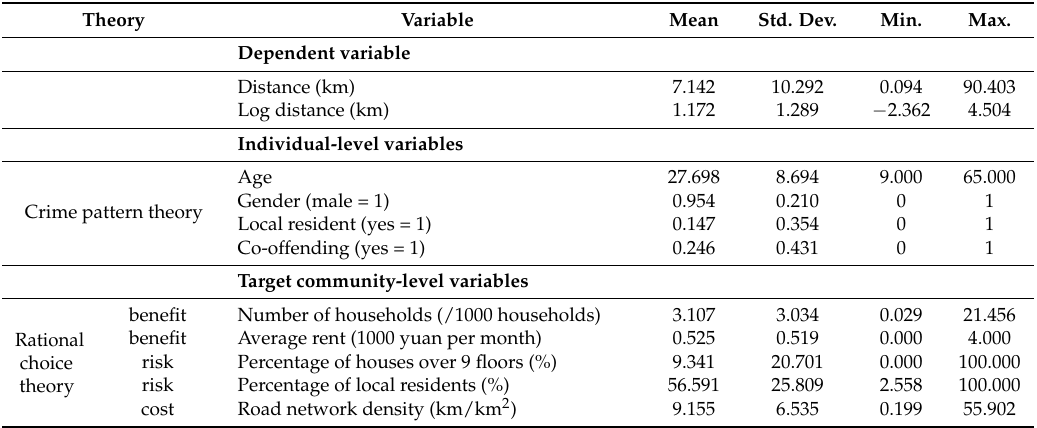
Table 1. Descriptive statistics of dependent and independent